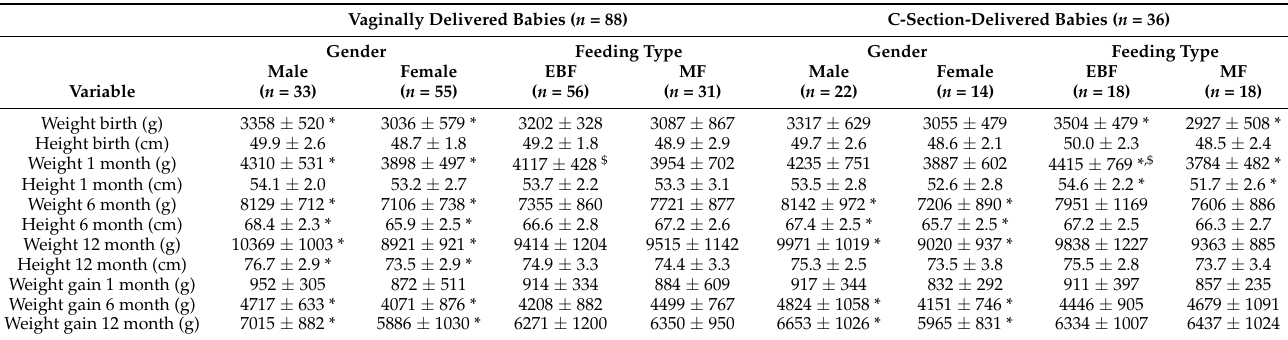
Table 3. Weight and weight gain during the first year of life in the infants included in this study as categorized by feeding type, gender and delivery